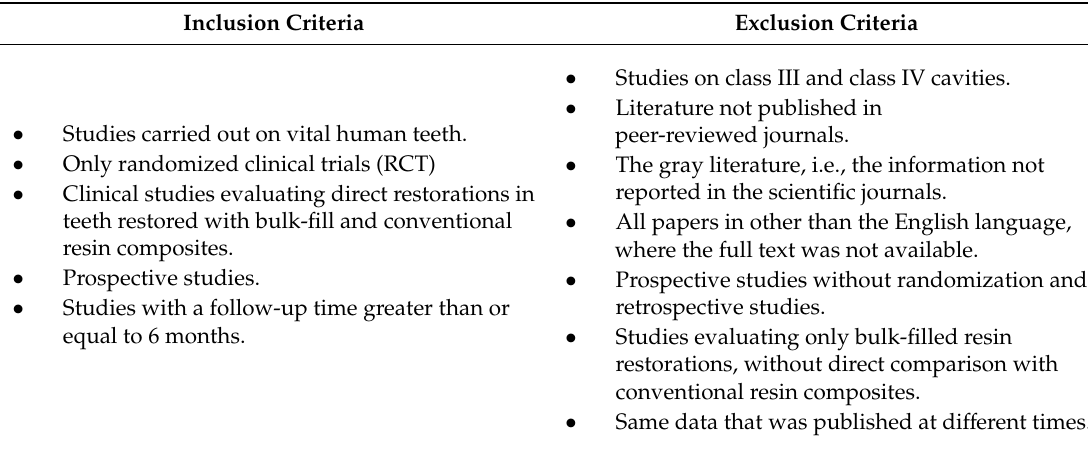
Table 1. The inclusion and exclusion criteria for